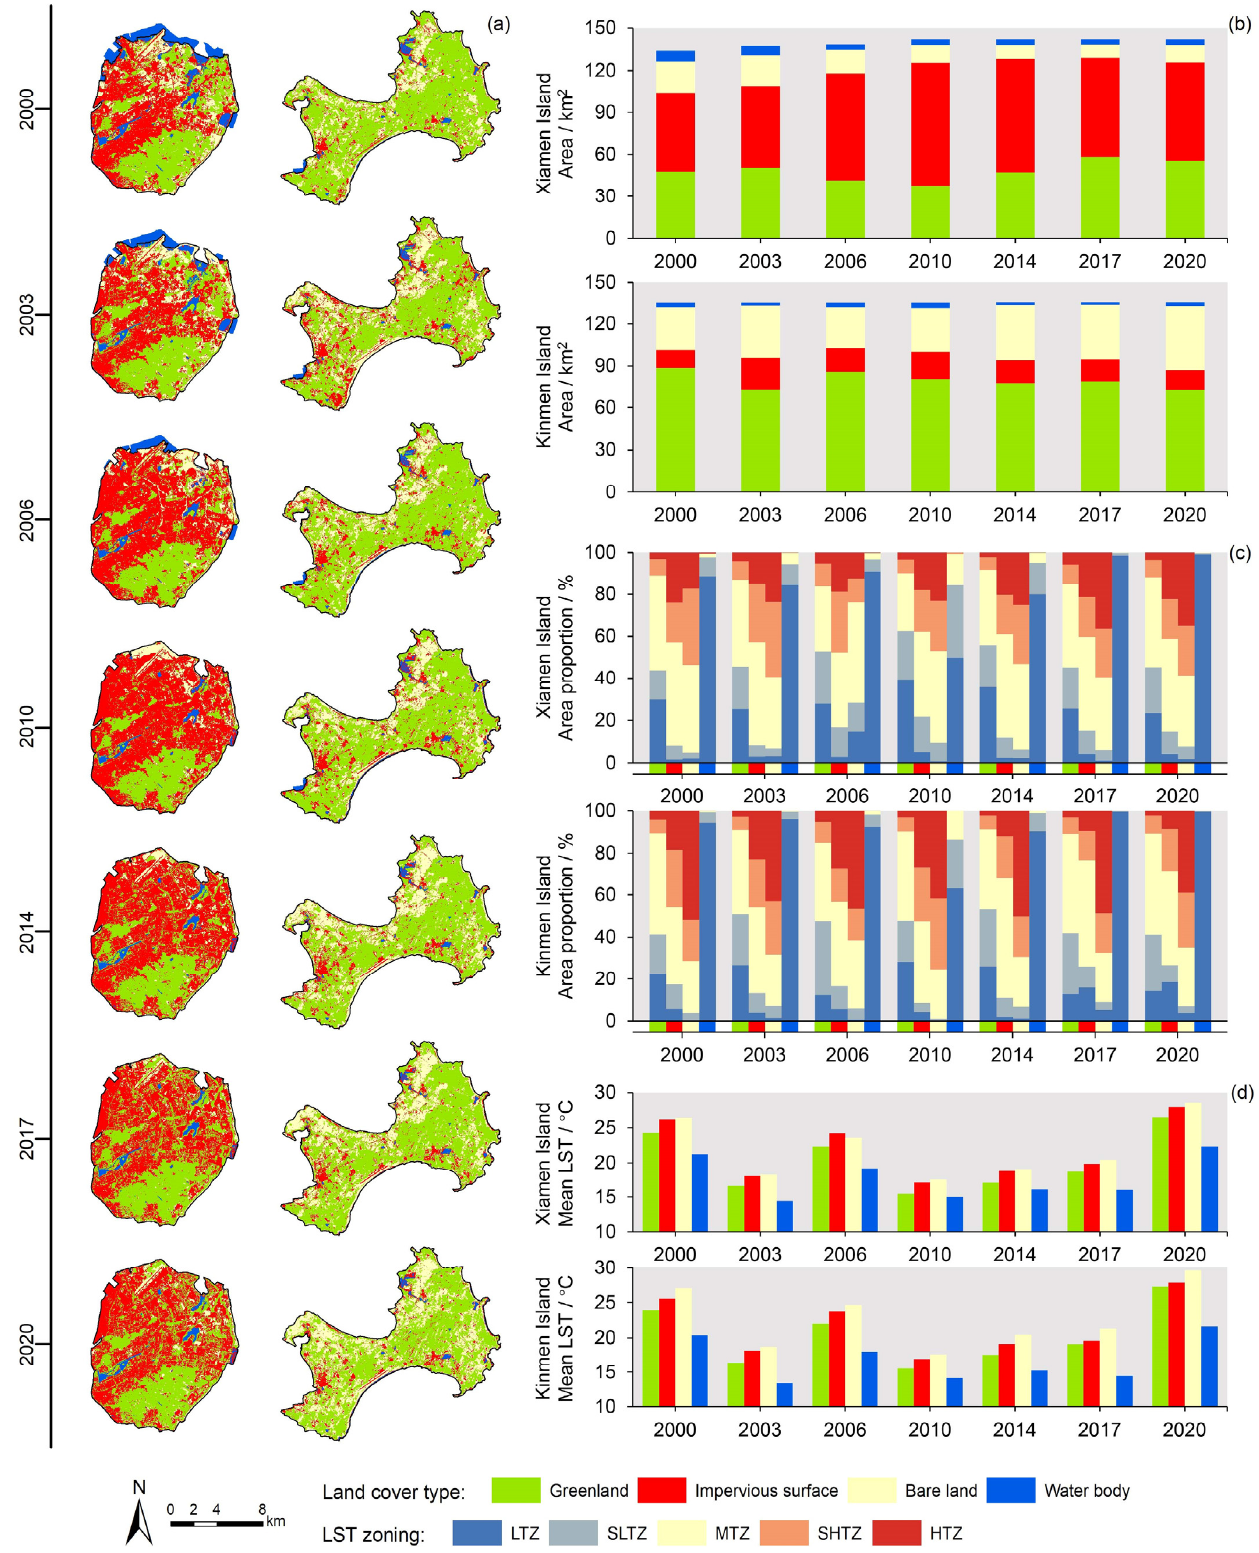
Figure 4. Spatiotemporal change in land cover and their effects on LST in the two islands from 2000 to 2020. ( a ) Identification results of land cover; ( b ) Change in the area of land cover types; ( c ) Area proportion of LST zones over different land cover types; ( d ) Comparison of mean LST over different land cover types.